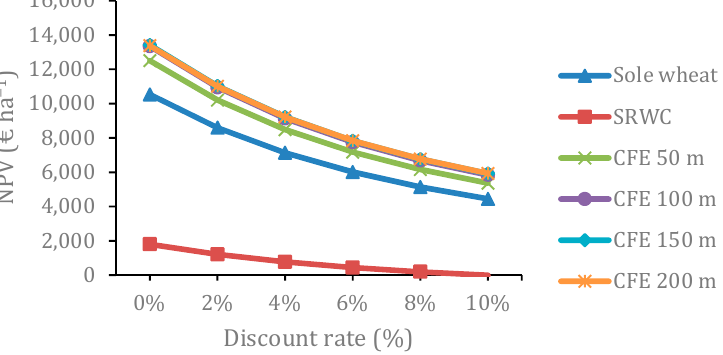
Figure 5. Net present value (NPV) sensitivity at 2–10% discount rates for the six scenarios.